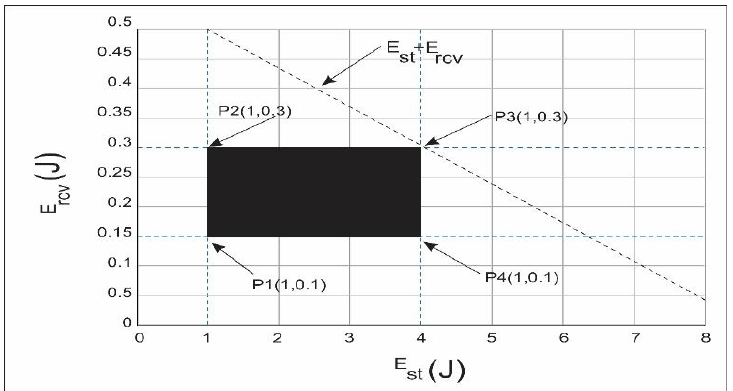
Figure 11. Possible feasible region of energy minimization.